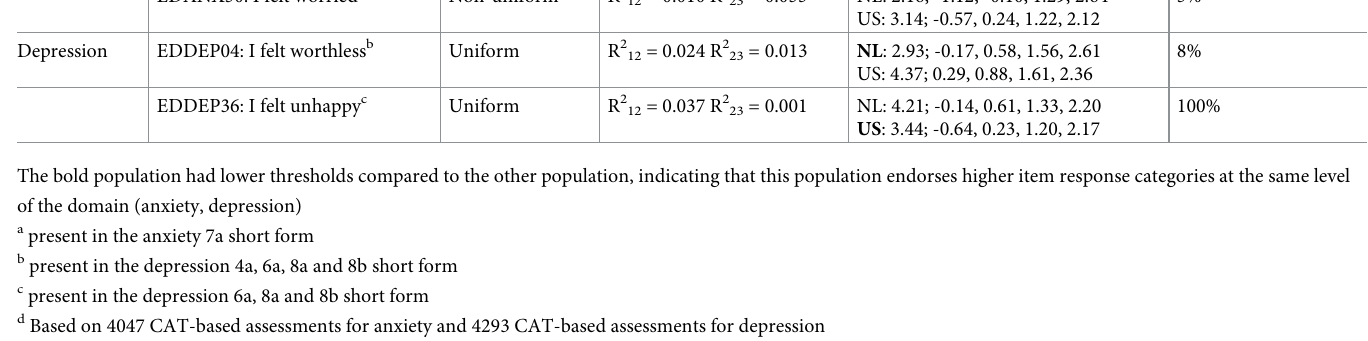
higher response categories at the same level of anxiety. The same applied for the item ‘I felt worthless’. For the item ‘I felt unhappy’, the threshold parameters for the Dutch population were slightly higher than the thresholds for the US population, indicating that the Dutch popu- lation endorses lower response categories at the same level of depression. Fig 1 illustrates the impact of DIF on respondents total scores. The plots on the left show the impact of DIF when all items are considered, whereas the plots on the right show the impact of DIF when only DIF items are considered. The plots show that DIF had a minimal impact on the total score when all items are administered in each item bank. S1 Fig shows the impact of DIF on item scores per group for the items displaying DIF.